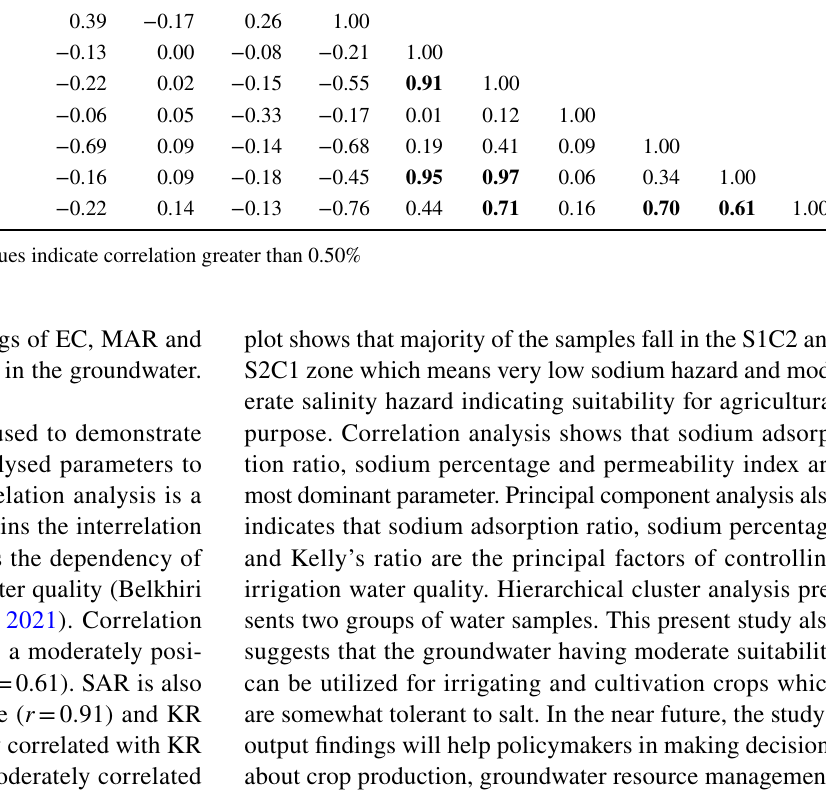
Table 5 Correlation analysis of irrigational groundwater quality parameters